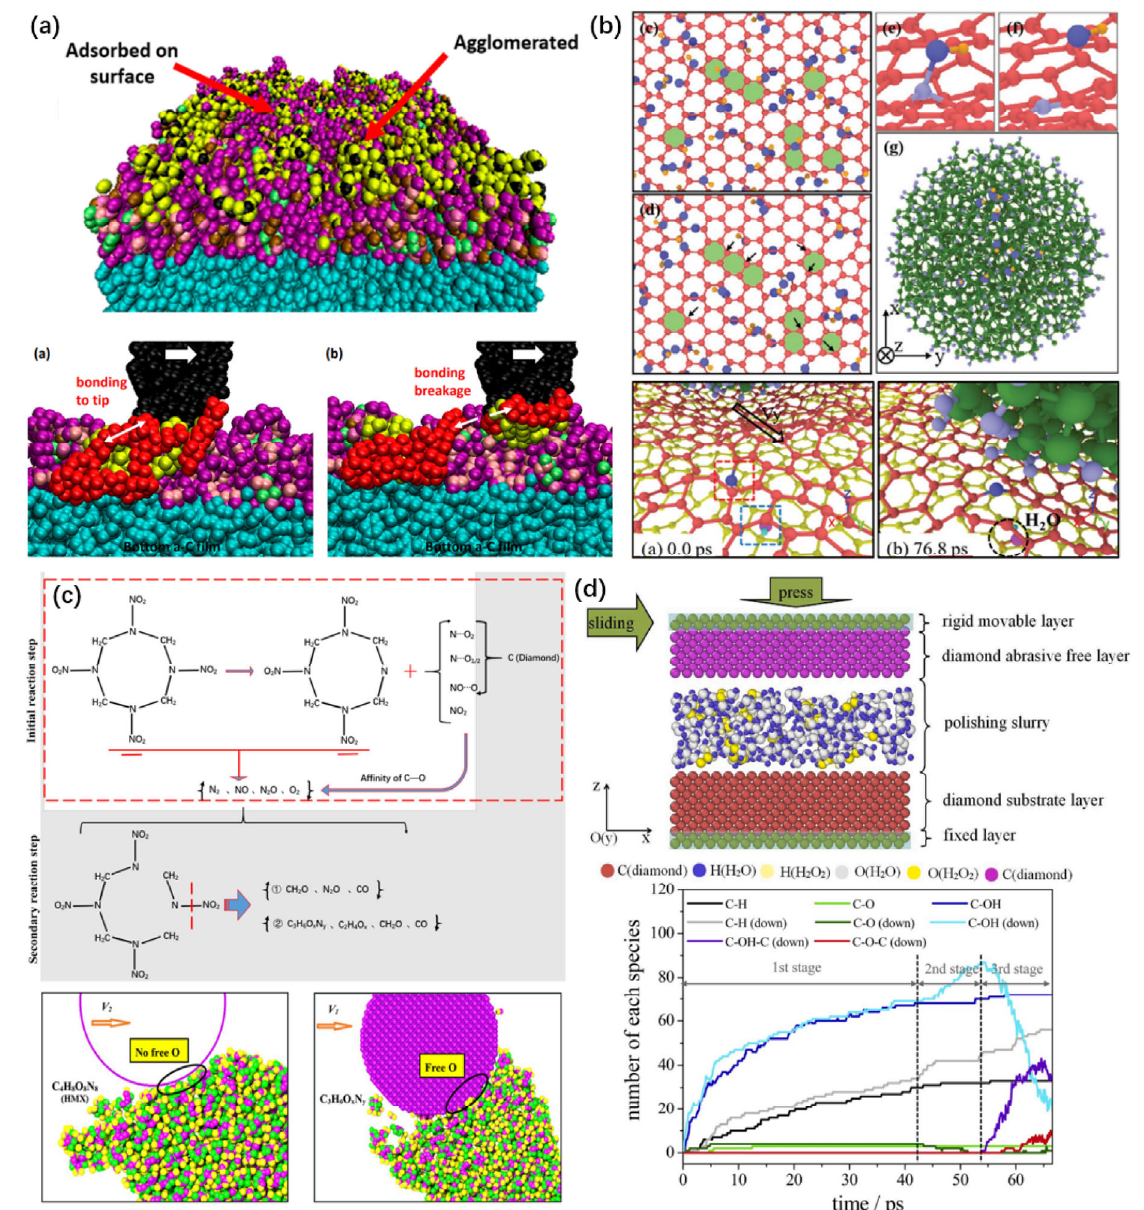
Fig. 83 Reactive molecular dynamics simulations of tribochemistry at sliding interface [978, 981, 984, 985]. Reproduced with permission from Ref. [978], © The author(s), 2021; Reproduced with permission from Ref. [981], © Wiley-VCH GmbH, 2020; Reproduced with permission from Ref. [984], © Emerald Publishing Limited, 2021; Reproduced with permission from Ref.